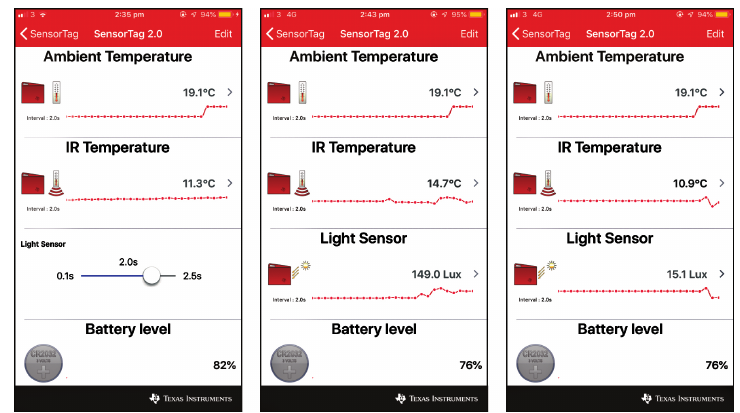
Figure 15. Broadcasting results with the CC2650 sensor